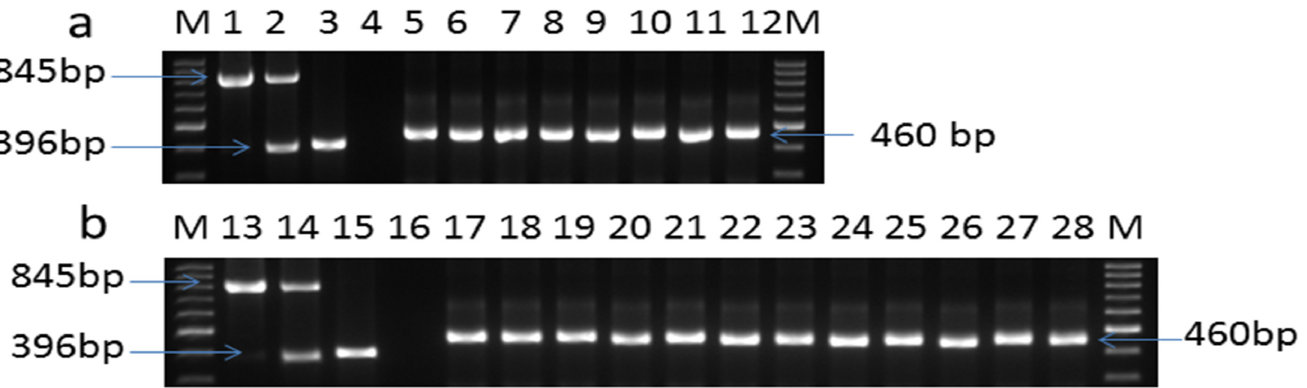
Fig 2. PCR detection of horizontal transfer of the neo transgene to the gut microbiota of transgenic pigs. a: Samples from Group A pigs: lane 1, neo positive control plasmid; lane 2, ear sample from a transgenic pig; lane 3, ear sample from a non-transgenic pig; lane 4, blank; lanes 5 – 8, fecal samples from transgenic pigs collected at day 0, day 8, day 23 and day 45 post antibiotic feeding; lanes 9 – 12, fecal samples from non-transgenic pigs collected at day 0, day 8, day 23 and day 45 post antibiotic feeding. b: Samples from group B pigs: lane 13, neo positive control plasmid; lane 14, ear sample from a transgenic pig; lane 15, ear sample from a non-transgenic pig; lane 16, blank; lanes 17 – 22, fecal samples from the duodenum, jejunum, ileum, cecum, colon, and rectum of transgenic pigs; lanes 23 – 28, fecal samples from the duodenum, jejunum, ileum, cecum, colon, and rectum of non-transgenic pigs. M: molecular weight markers. 845 bp: PCR product of neo gene and SV40 promoter (primers P3 and P4); 396 bp: PCR product of the porcine beta-actin gene (primers P5 and P6); 460 bp: PCR product of 16S rDNA (primers P7 and P8).